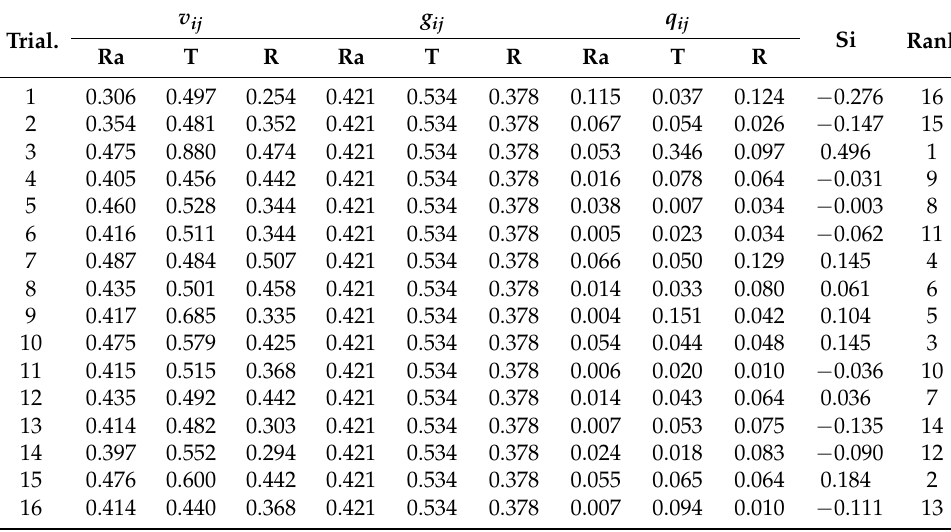
Table 5. Calculated results when using MABAC and MEREC methods.